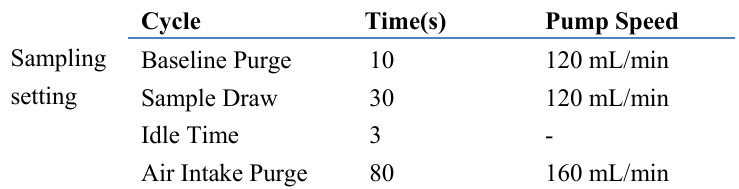
Table 2. E-nose parameter settings for honey, syrup and adulterated samples